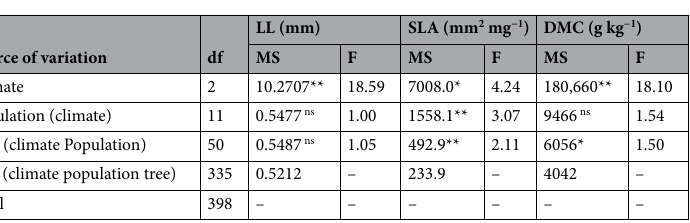
Table 1. Leaf morphological traits in ANOVA hierarchical model between three different climates. LL: Leaf length, SLA: specific leaf area, DMC: dry matter content.